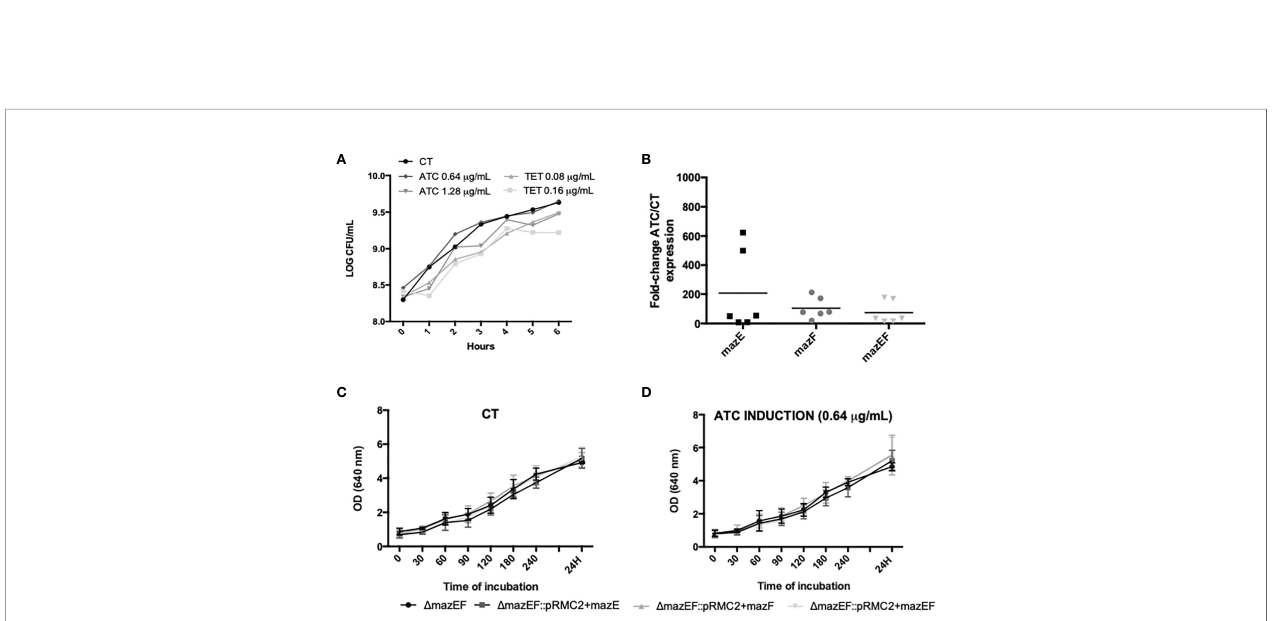
FIGURE 4 | Study of the putative TA action of mazEF homologue. (A) Growth curve of D mazEF planktonic cells upon incubation with different concentrations of anhydrotetracycline (ATC) and tetracycline (TET). The control (CT) data refers to non-induced cells. The data presented are relative to a single assay; (B) Fold-change expression of the mazEF homologue genes upon 4 h of induction with ATC 0.64 m g/ml. D mazEF cells harboring the inducible plasmids but without induction were used as control. Each point represents a single experiment and the horizontal lines represent the mean of 6 independent experiments; (C) Optical density (OD) of the control strains; and (D) strains induced with 0.64 m g/ml of ATC. Results are represented as the mean + standard deviation of at least 3 independent assays (C, D) . Statistical analysis was completed with One-way ANOVA with Tukey ’ s multiple comparisons test (B – D)